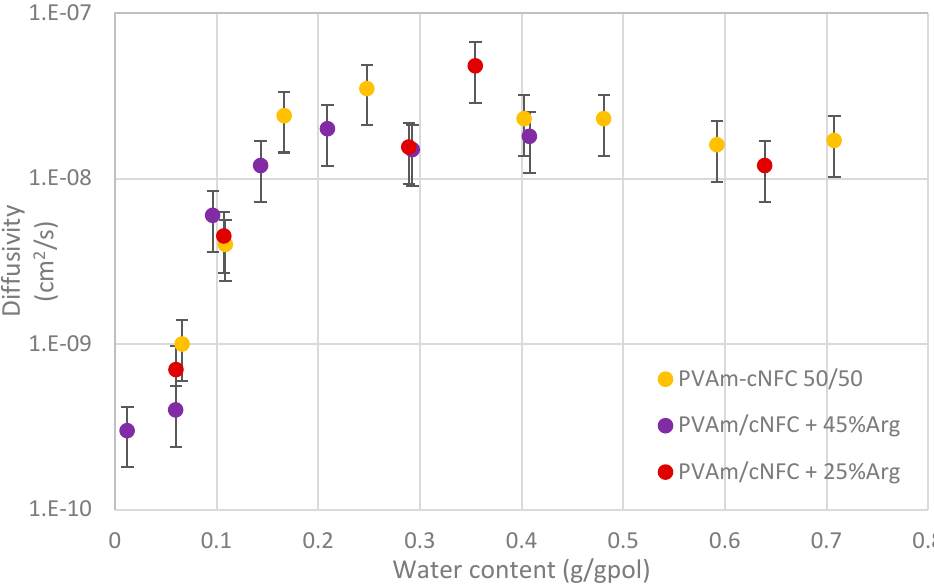
Figure 7. Diffusion coefficient of water in the different inspected materials as obtained through Equation (2).